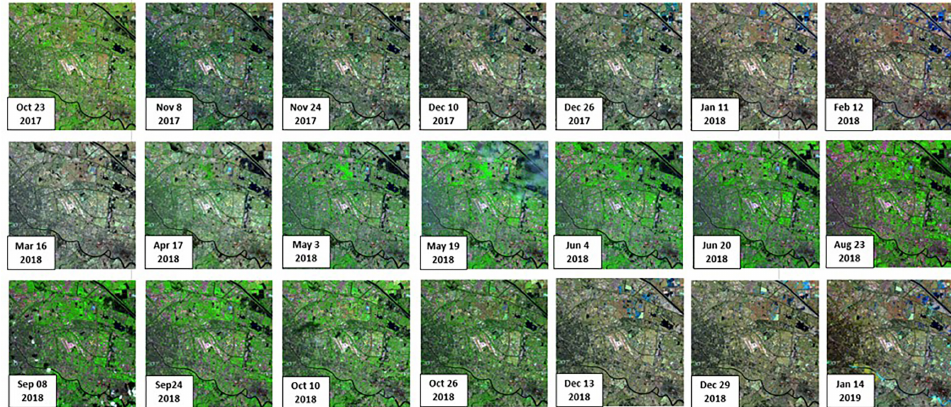
Figure 6. The relative radiometric normalized images in SITS. Figure 7 is a mosaic image composed of four normalized images taken from 10 and 26 December 2017, and 13 and 29 December 2018, respectively. In untreated images shown in Figure 4, there exists significant differences in color intensity and color saturation between images acquired on December 2017 and 2018. However, in normalized images shown in Figure 7a, we can see that all have similar radiometric intensity, hue and color saturation to each other.